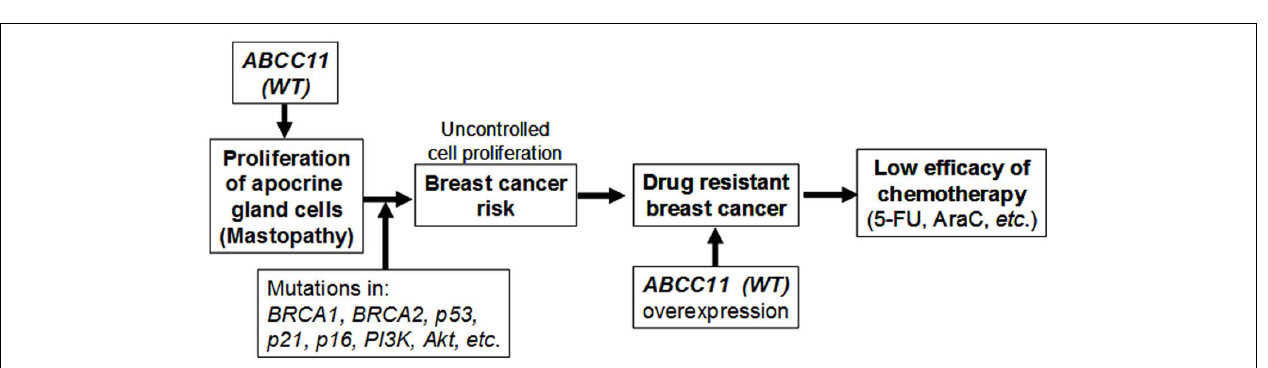
ABCC11WT and sequestered in intracellular granules and vacuoles. SNP variant R180 lacking N -linked glycosylation is recognized as a misfolded protein in the ER and readily undergoes ubiquitination and proteasomal degradation (ERAD pathway). ER, endoplasmic reticulum; ERAD, ER-associated degradation.This scheme is modified from Toyoda etal. (2009).